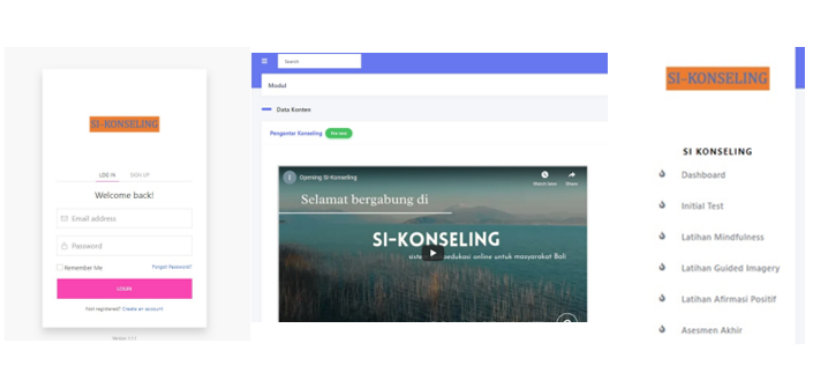
Figure 2. The appearance of SI-Konseling (Figure with permission ©Suranata, et.,all